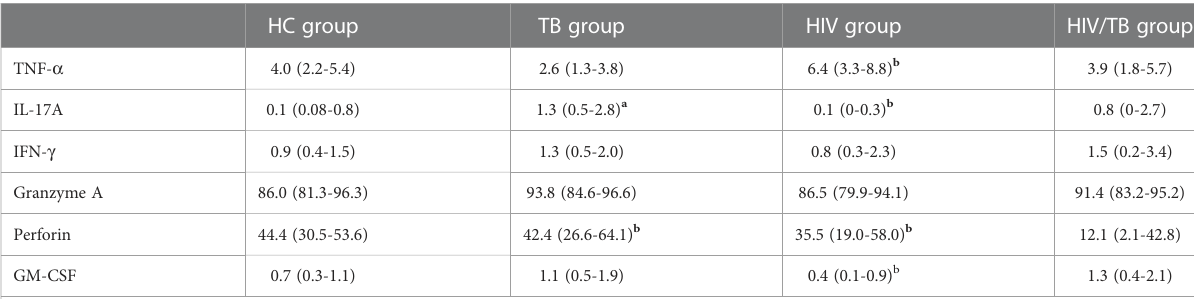
TABLE 3 The frequency of gd T cells produced different cytokines.